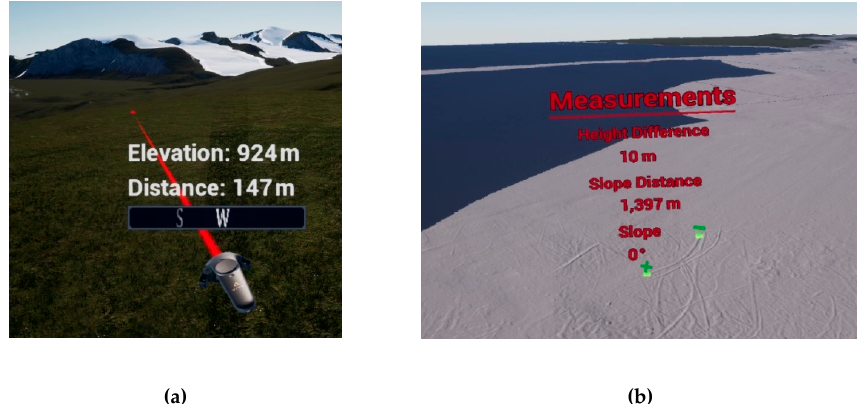
Figure 13. The left and right motion controller in VR where the left controller holds the elevation, distance, and compass measurements and the right controller holds the locomotion possibilities ( a ).